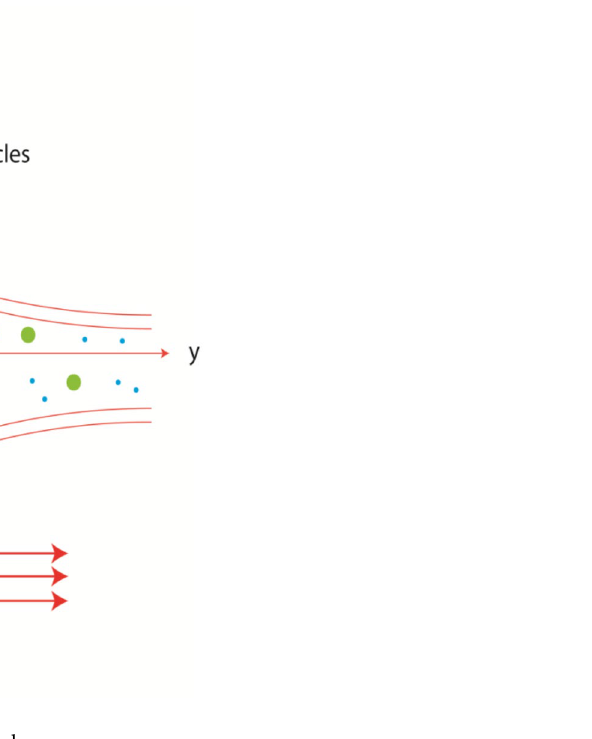
Figure 2. Geometrical view of flow